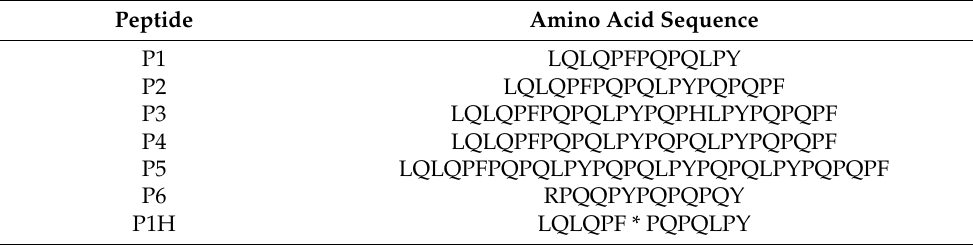
Table 1. The peptides investigated by targeted LC-MS. Amino acid sequence displays one letter amino acid